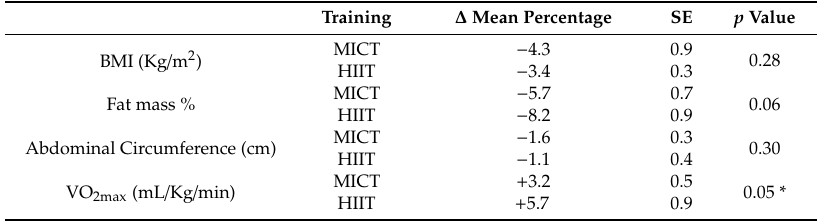
Table 5. Comparison of ∆ (T1 − T0) mean percentage between MICT and HIIT for BMI, Fat mass %, Abdominal Circumference and VO 2max . Analysis was performed using one-way ANOVA; for each parameter, we indicated the mean percentage ( ∆ Mean percentage), the Standard Error (SE) and p value. * p -value ≤ 0.05. Training